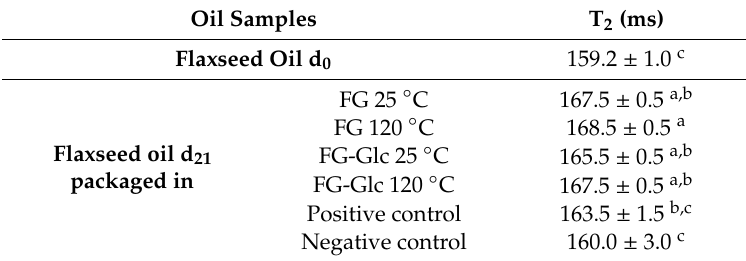
Figure 5. Free fatty acid content of flaxseed oil packaged or not in different gelatin pouches as a function of storage time. Means with different superscripts (a-j) indicate a significant difference ( p ˂ 0.05). Table 1. Intrinsic viscosity of flaxseed oil at d 0 and after application (d 21 ) determined via